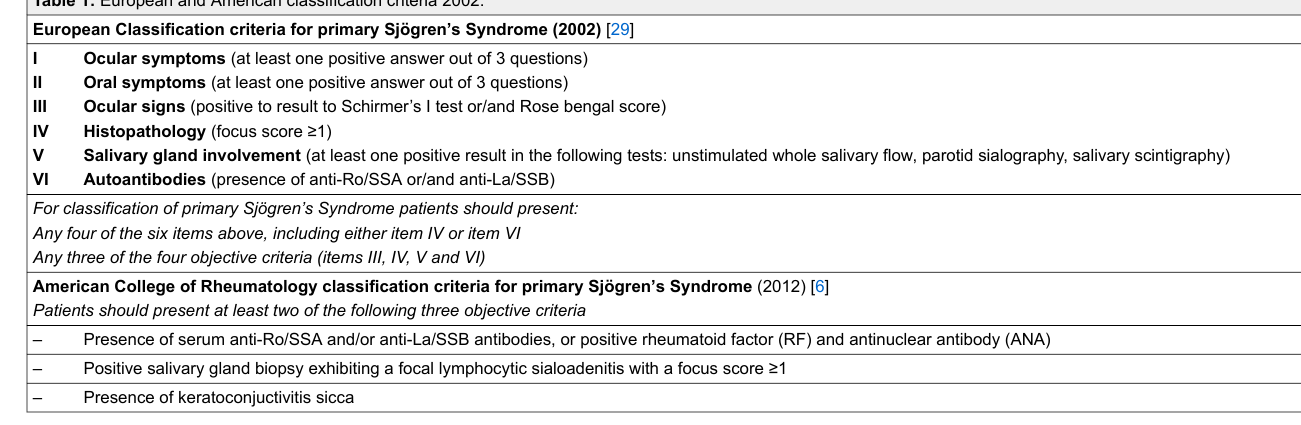
Table 1: European and American classification criteria